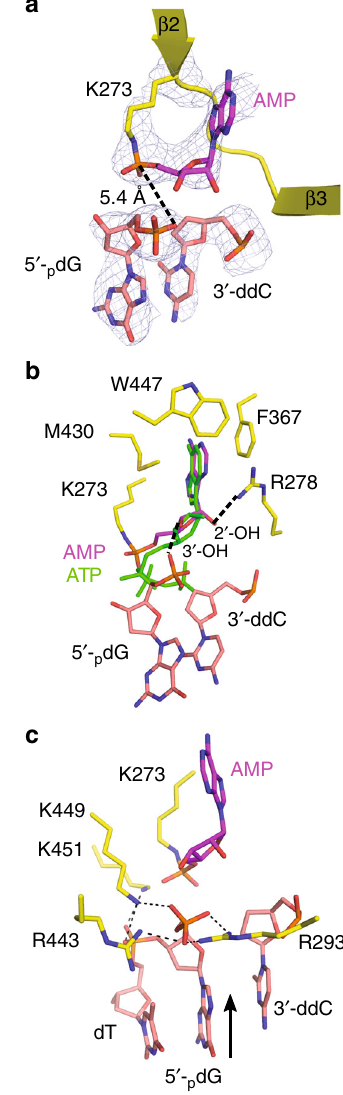
Fig. 2 Detailed analysis of the lysyl-adenylate complex. a Disposition of the LigIV lysyl-adenylate (magenta) covalently linked to Lys273, relative to the nick in the DNA backbone (pink). The interatomic distance between the oxygens on the 5 ′ -phosphate on the downstream primer and the phosphorous atom of the AMP is indicated by the black dashed line map (gray) is shown, contoured at 2.5 σ . b Interactions with the lysyl- adenylate (magenta) and the protein residues (yellow) lining the nucleotide-binding site. Putative hydrogen-bonding interactions with the AMP hydroxyls are indicated by black dashed lines, and are listed in detail in Supplementary Table 2. The LigIV apoprotein structure (PDB ID code 3W5O 20 ) was superimposed onto the DNA-bound structure, and the position of its ATP molecule is shown in green. c Nick sensing by LigIV involves multiple putative interactions (black dashed lines) between protein sidechains (yellow), the adenylate (magenta), and the 5 ′ -phosphate on the DNA (pink). The nick junction is indicated by a black